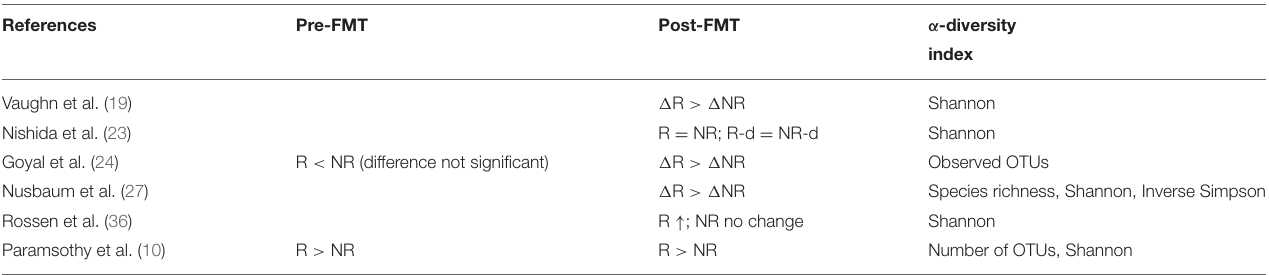
TABLE 3 | Comparison of α -diversity between responders and